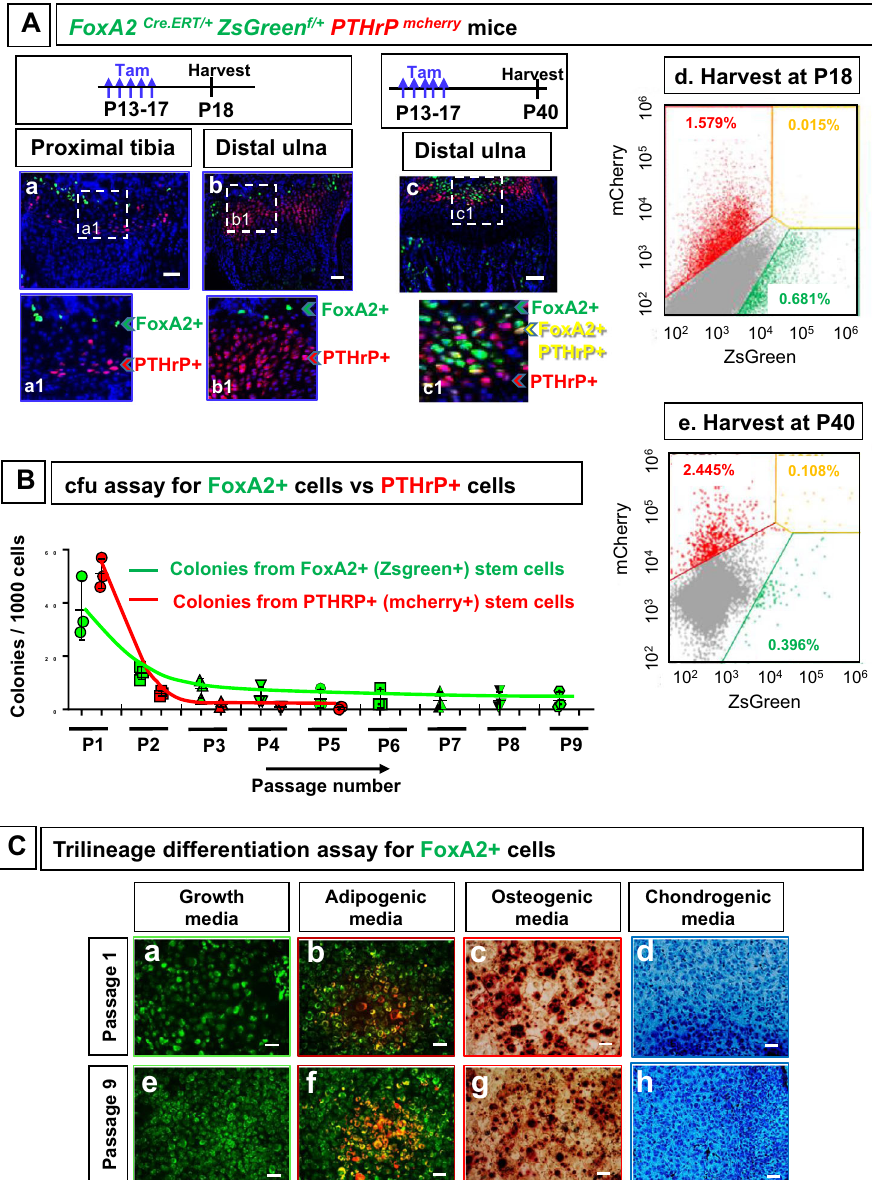
Fig. 3 FoxA2 + cells are long-term stem cells, and they are distinct from the short-term PTHrP + stem cells. A Tibia ( a ) and ulna ( b ) from FoxA2 CreERT2/ + ; ZsGreen fl / + ;PTHrP mcherry mice treated with tamoxifen (Tam) P13-P17 and harvested at P18, and from FoxA2 CreERT2/ + ;ZsGreen fl / + ;PTHrP mcherry mice treated with tamoxifen P13-P17 and harvested at P40 ( c ). Florescence microscopy for ZsGreen (green), mcherry (red), Hoechst (blue). Scale bars, 50 µ m. Separation of FoxA2 + (green) cells from PTHrP + (red) cells and double positive FoxA2 + PTHrP + (yellow) cells by Fluorescence-activated cell sorting (FACS) of GP cells isolated from FoxA2 CreERT2/ + ;ZsGreen fl / + ; PTHrP mcherry mice, injected with tamoxifen from P13 to P17, and harvested at P18 ( d ) or P40 ( e ). B Colony forming unit (cfu) assay for FoxA2 + (ZsGreen + ) cells (from FoxA2 CreERT2/ + ;ZsGreen fl / + ;col.10 mcherry mice treated with tamoxifen P13-P17 and harvested at P18) and PTHrP + (mcherry + )cells (from PTHrP mcherry mice harvested at P18). Quanti fi cation of the number of colonies (per 10 3 cells) presented as mean±SD from n = 3 experiments. C Trilineage differentiation of FoxA2 + (ZsGreen + ) clones, from passage P1 ( a – d ) and passage P9 ( e – h ). Four independent clones, for each passage, were tested in either growth media ( a , e ), or adipogenic ( b , f ), osteogenic ( c , g ) and chondrogenic ( d , h ) media. Scale bars, 100 µ